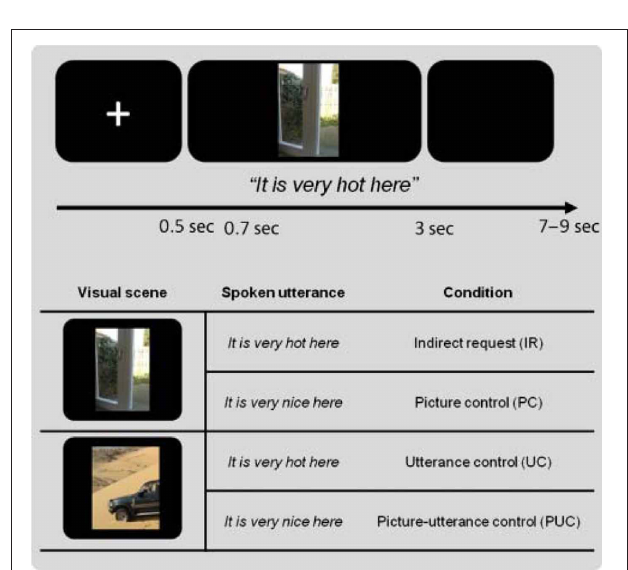
taken as an arbitrary zero in the diagram). The vertical lines indicate the standard error for each condition. C + P + : Congruent, with pitch accent; C + P–: Congruent, without pitch accent; C–P + : Incongruent, with pitch accent; C–P–: Incongruent, without pitch accent (from Kristensen et al., 2012).